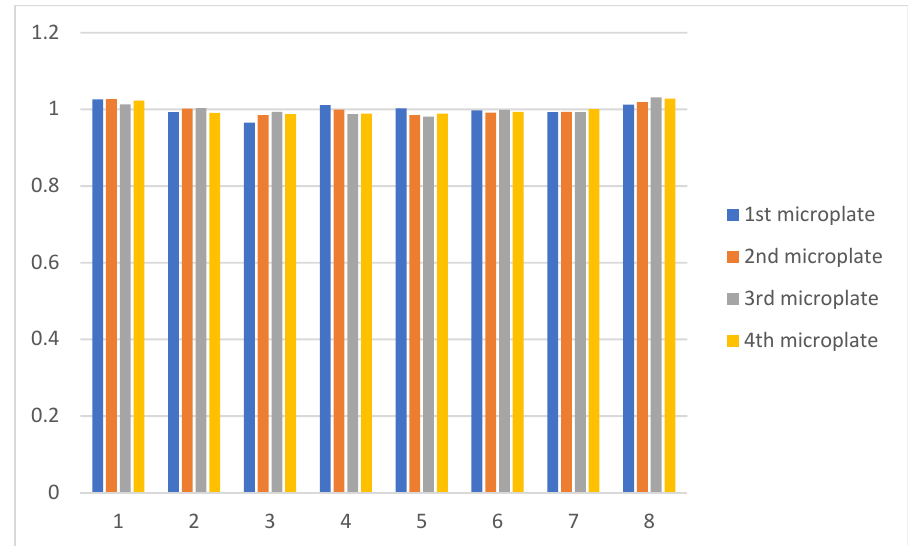
Figure 5. Normalized velocity distribution from the 1st to the 4th microplate of the numbering ‐ up microreactor at inlet gas flow rate Y g = 274.8 mL/min and Re = 76.32.